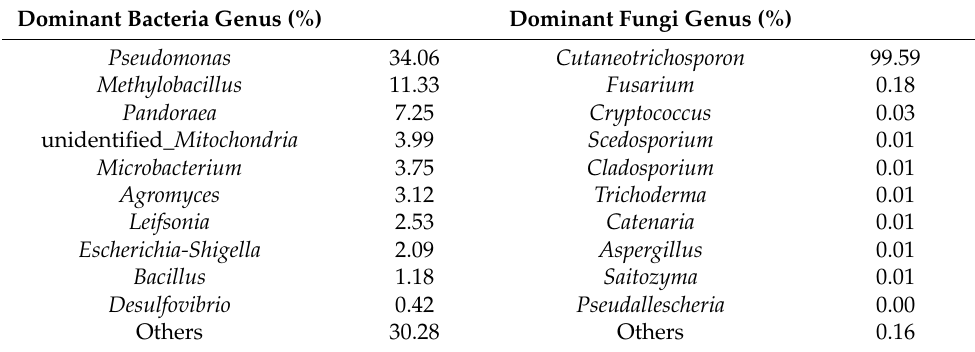
Figure 2. The relative abundance of microbial communities in monitoring tank 8 (NH. W2). The relative abundance is shown as a percentage. Phylum and genera are colored according to the legend on the right. ( A ) Relative abundance of bacteria at phylum level. ( B ) Relative abundance of bacteria at genera level. ( C ) Relative abundance of fungi at phylum level. ( D ) Relative abundance of fungi at genera level. Table 4. Relative abundance of dominant bacteria and dominant fungi of the desalination buffer in the NH.W2 at the genus level.